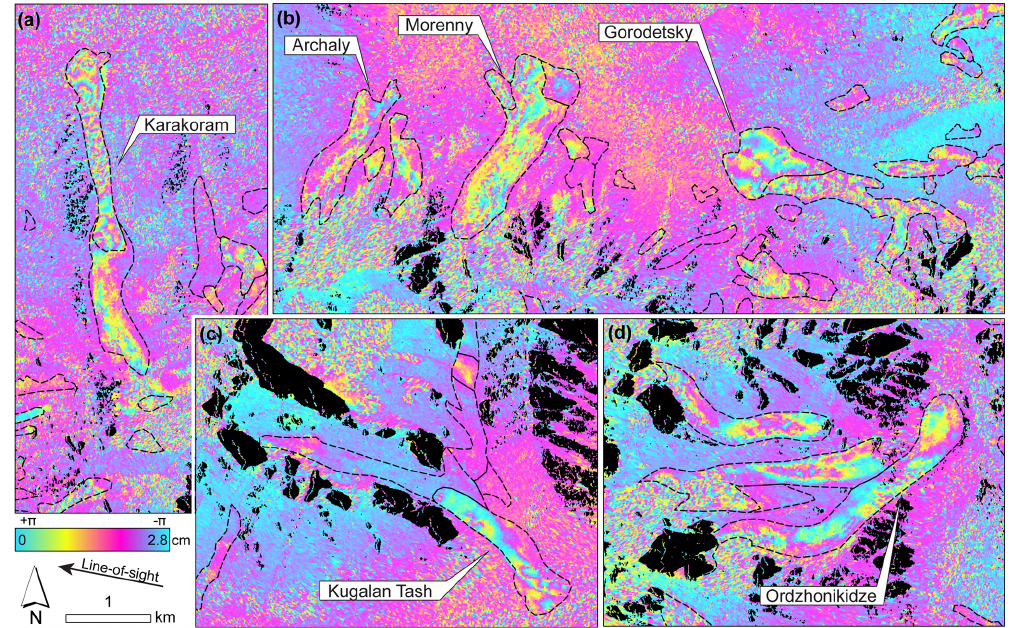
Figure 2. Wrapped orthorectified interferogram between descending Sentinel-1 C-band radar (5.6cm wavelength) data on 24 August and 5 September 2018 (12d). Black areas are due to radar layover and shadow. The black dashed lines are the inventory outline polygons from our motion classes. Panels (a) – (d) show interferogram sections of the rock glaciers investigated in detail